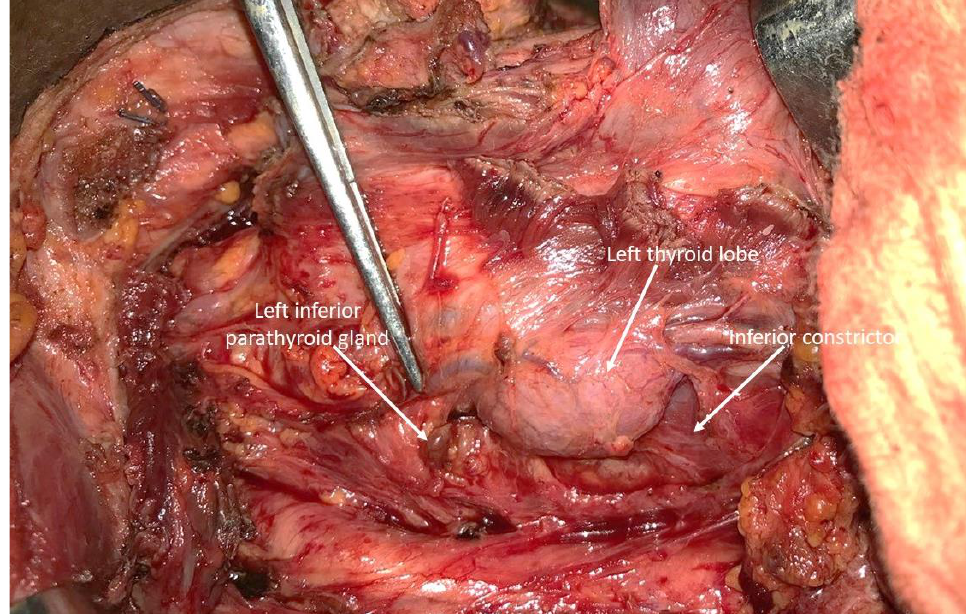
Figure 1. Intraoperative view of the left side of the neck showing the inferior parathyroid found in-situ by the surgeon on visual assessment.